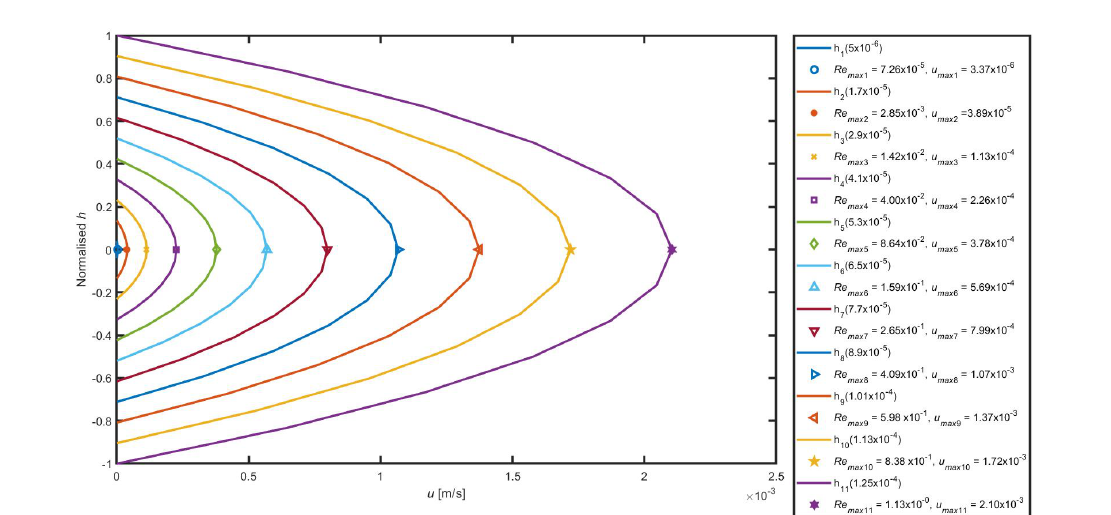
Figure 3. Normalised channel thickness profile as a function of velocities computed in a spatially heterogeneous porous